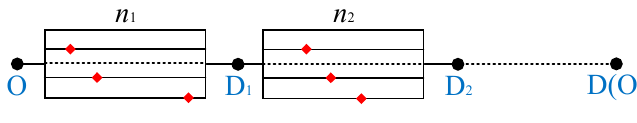
Figure 7. A set of potential trip chains.